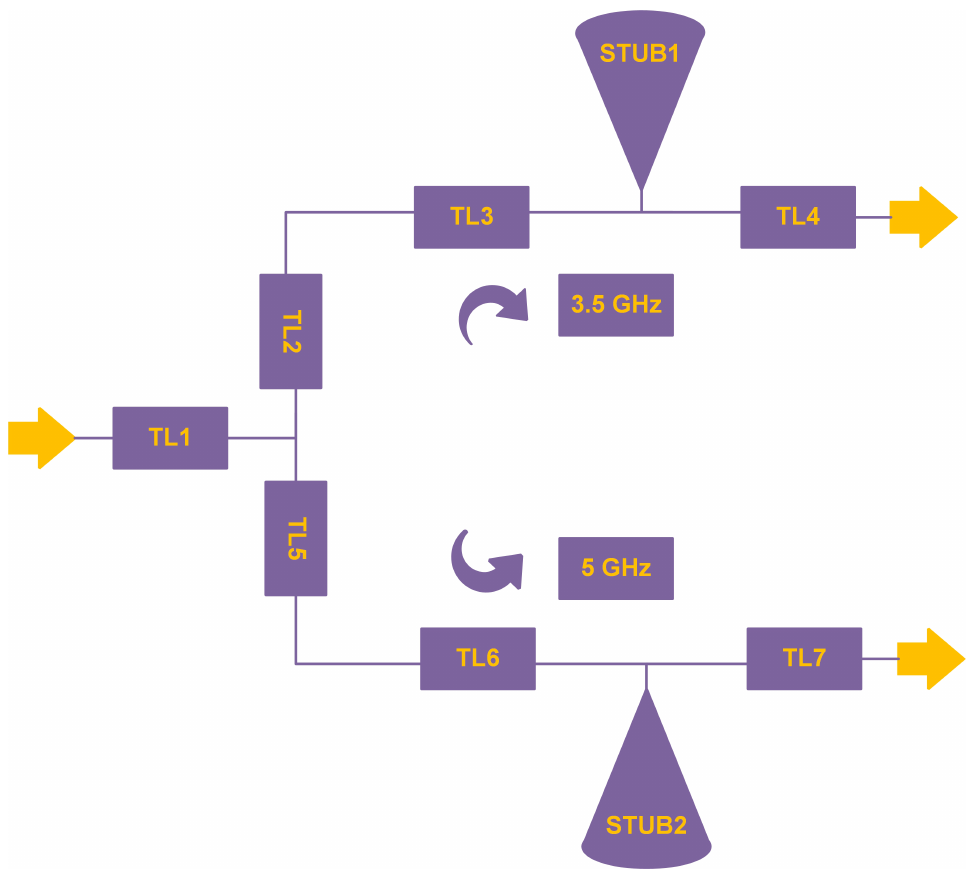
Figure 4. Proposed impedance-matching